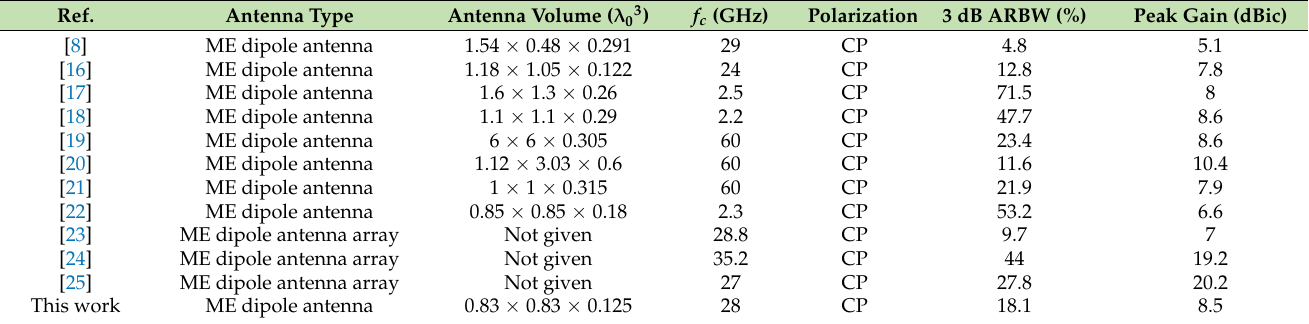
Table 2. Performance comparison of the proposed CP ME dipole antenna with the reported works.